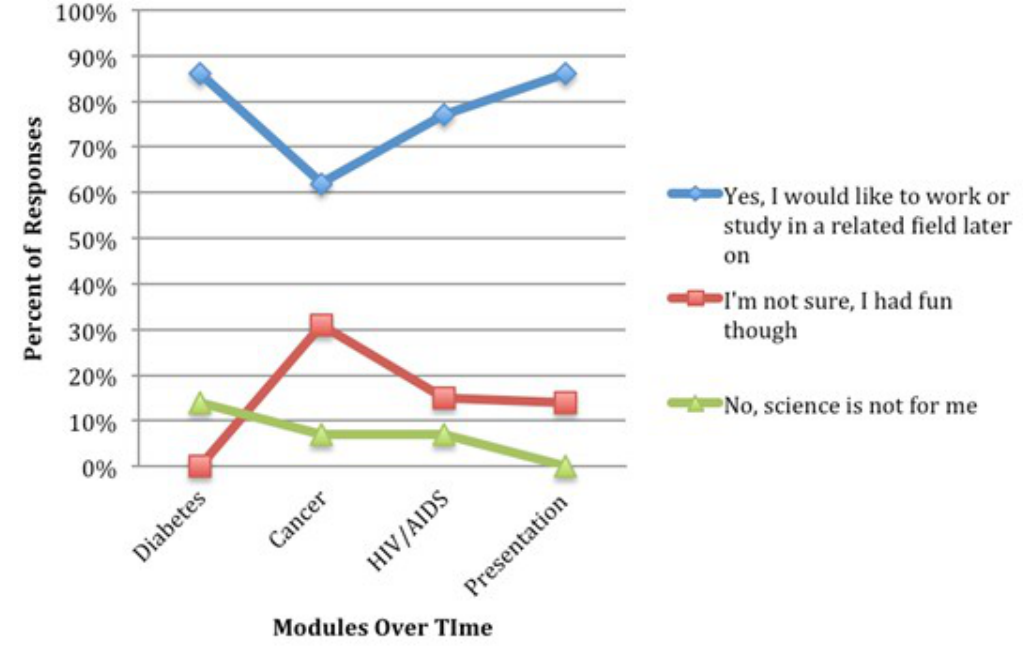
Figure 2. Students were asked “Has This Lesson Triggered Your Interest in Science For the Future” and their responses (taken from anonymous evaluatons) are charted over the four modules